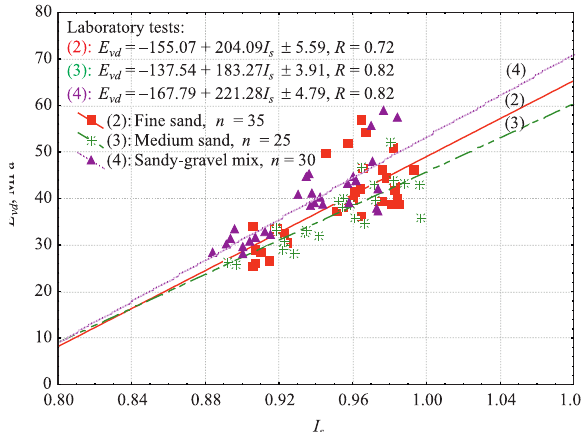
Fig. 5. Dependence E vd = f ( I s ) for data from laboratory tests: (2) – fine sand; (3) – medium sand; (4) – sandy-gravel mix